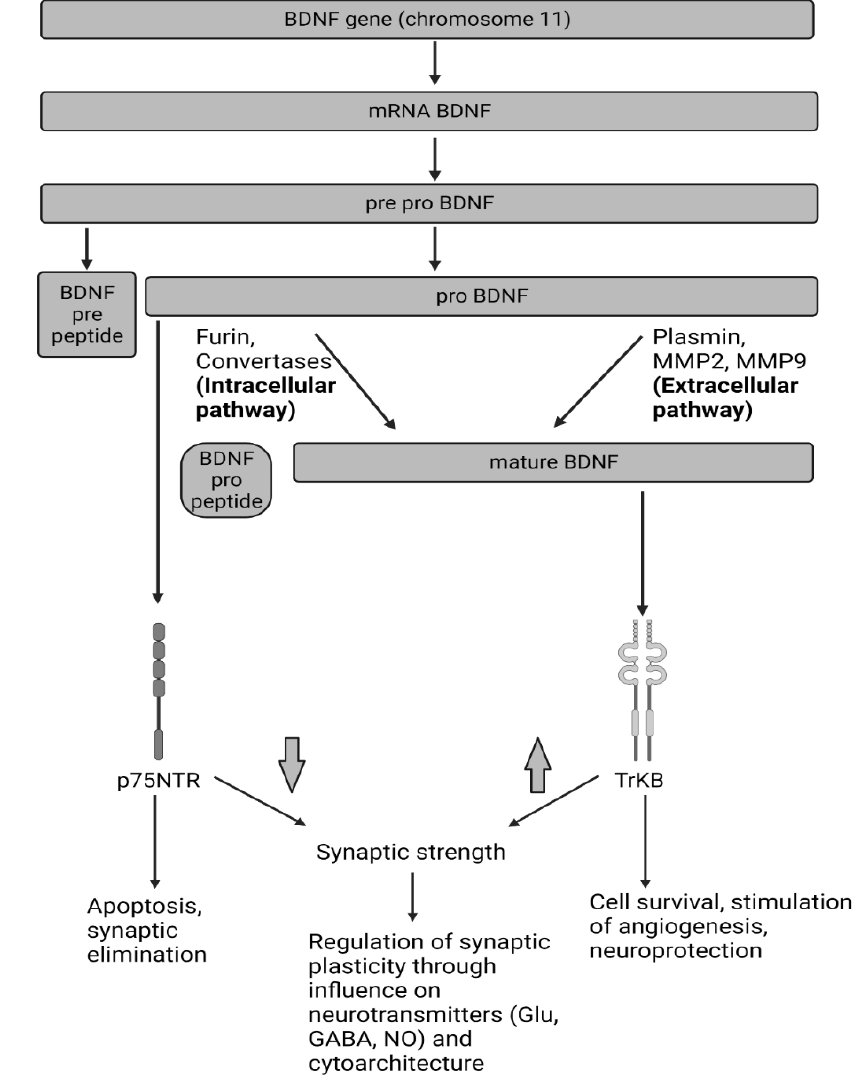
Figure 1. BDNF signaling pathways. BDNF is translated as its isoform, preproBDNF. In the Golgi apparatus, preproBDNF is cleaved, which produces proBDNF. ProBDNF might be split into